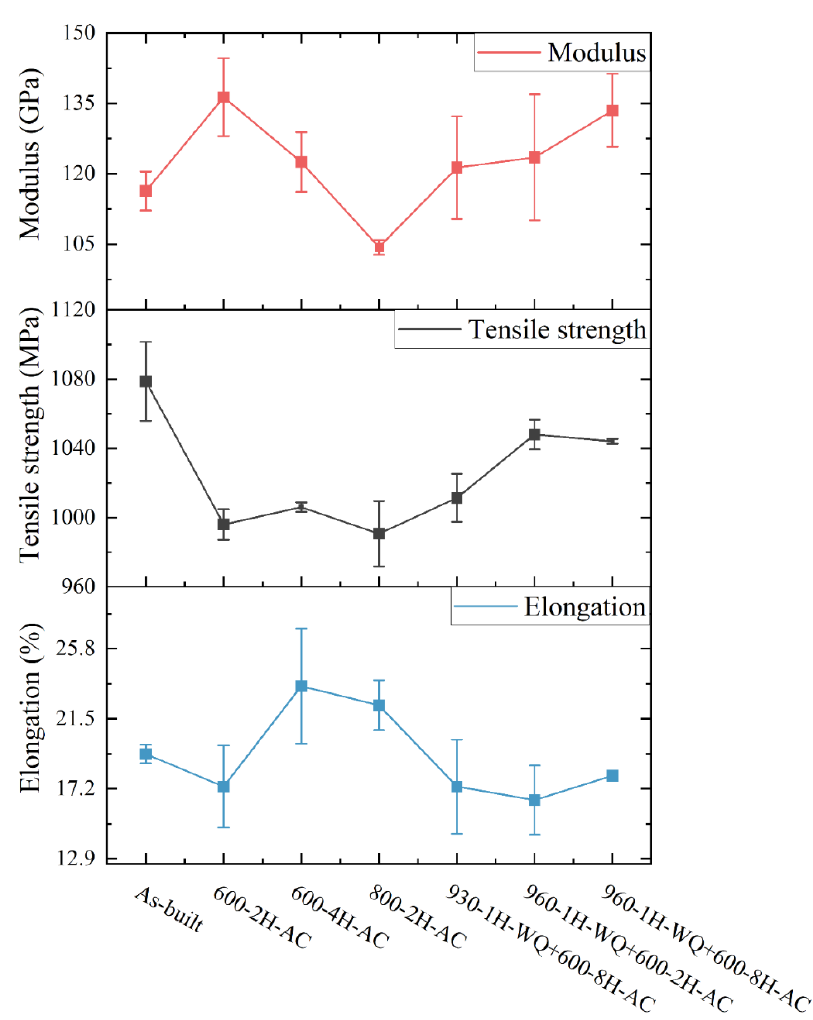
Figure 12. Tensile properties of SLM TC4 under different heat treatments.